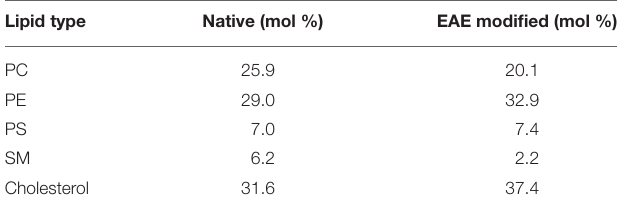
TABLE 1 | Lipid compositions of native and EAE modified cytoplasmic myelin membranes (Krugmann et al.,